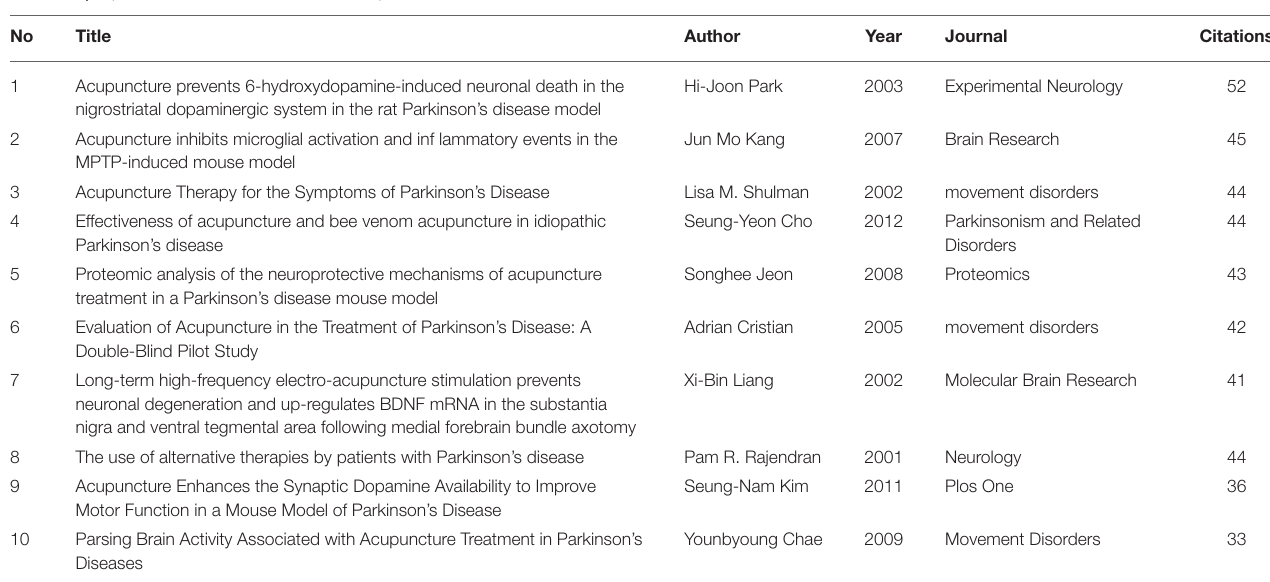
TABLE 6 | Top references in the treatment of acupuncture for